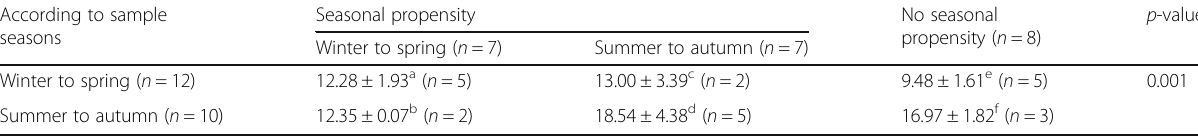
Table 3 The 25(OH)D concentration according seasonal propensity and sample seasons in 22 CH patients with recurrence According to sample Seasonal seasons